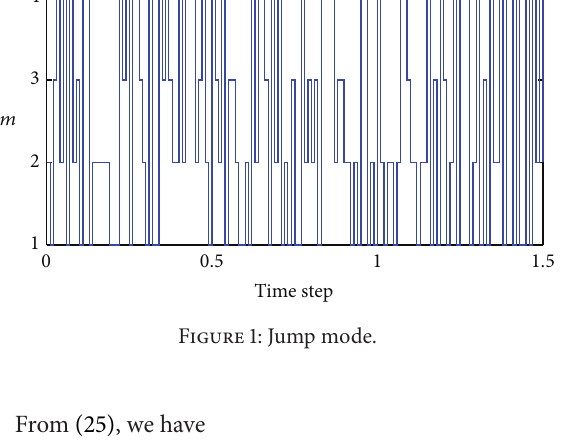
Figure 1: Jump mode.